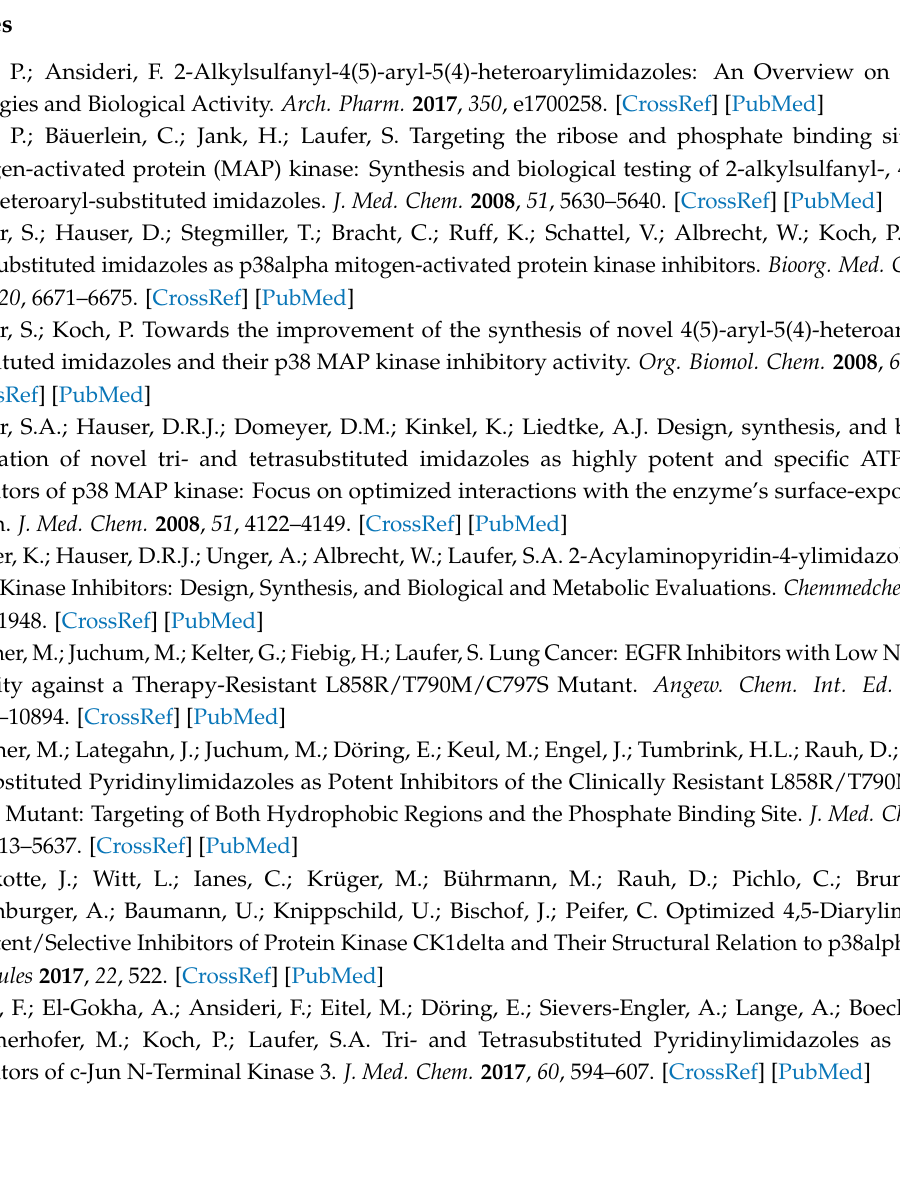
Supplementary Materials: The following are available online, Figure S1: 1 H-NMR of 2 ; Figure S2: 13 C-NMR of 2 ; Figure S3: ESI-MS of 2 ; Figure S4: HPLC of 2 ; Figure S5: IR of 2 ; Figure S6: UV-VIS of 2